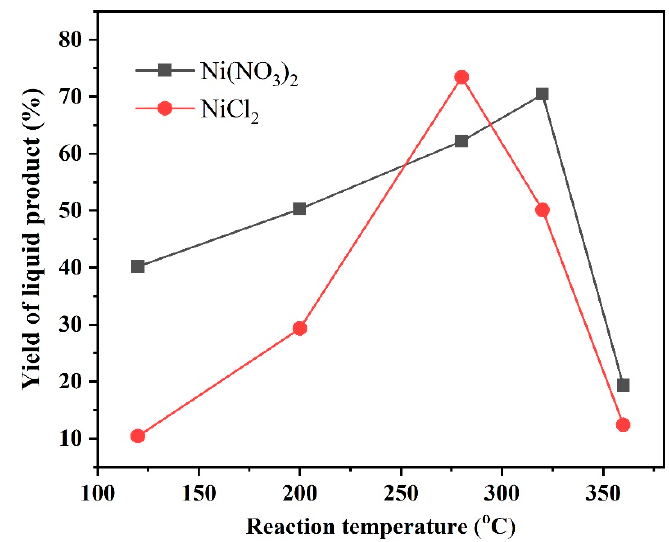
Figure 6. E ff ect of Ni precursor on the yield of liquid product. Reaction conditions: Si / Al ratio: 25; pressure: 3.5 MPa; WHSV: 2.0 h − 1 ; aging temperature: room temperature; pretreatment temperature: 300 ° C.